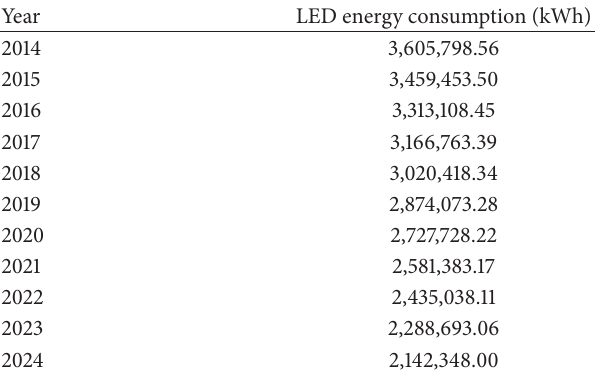
Table 5: Energy consumption between existing and alternative